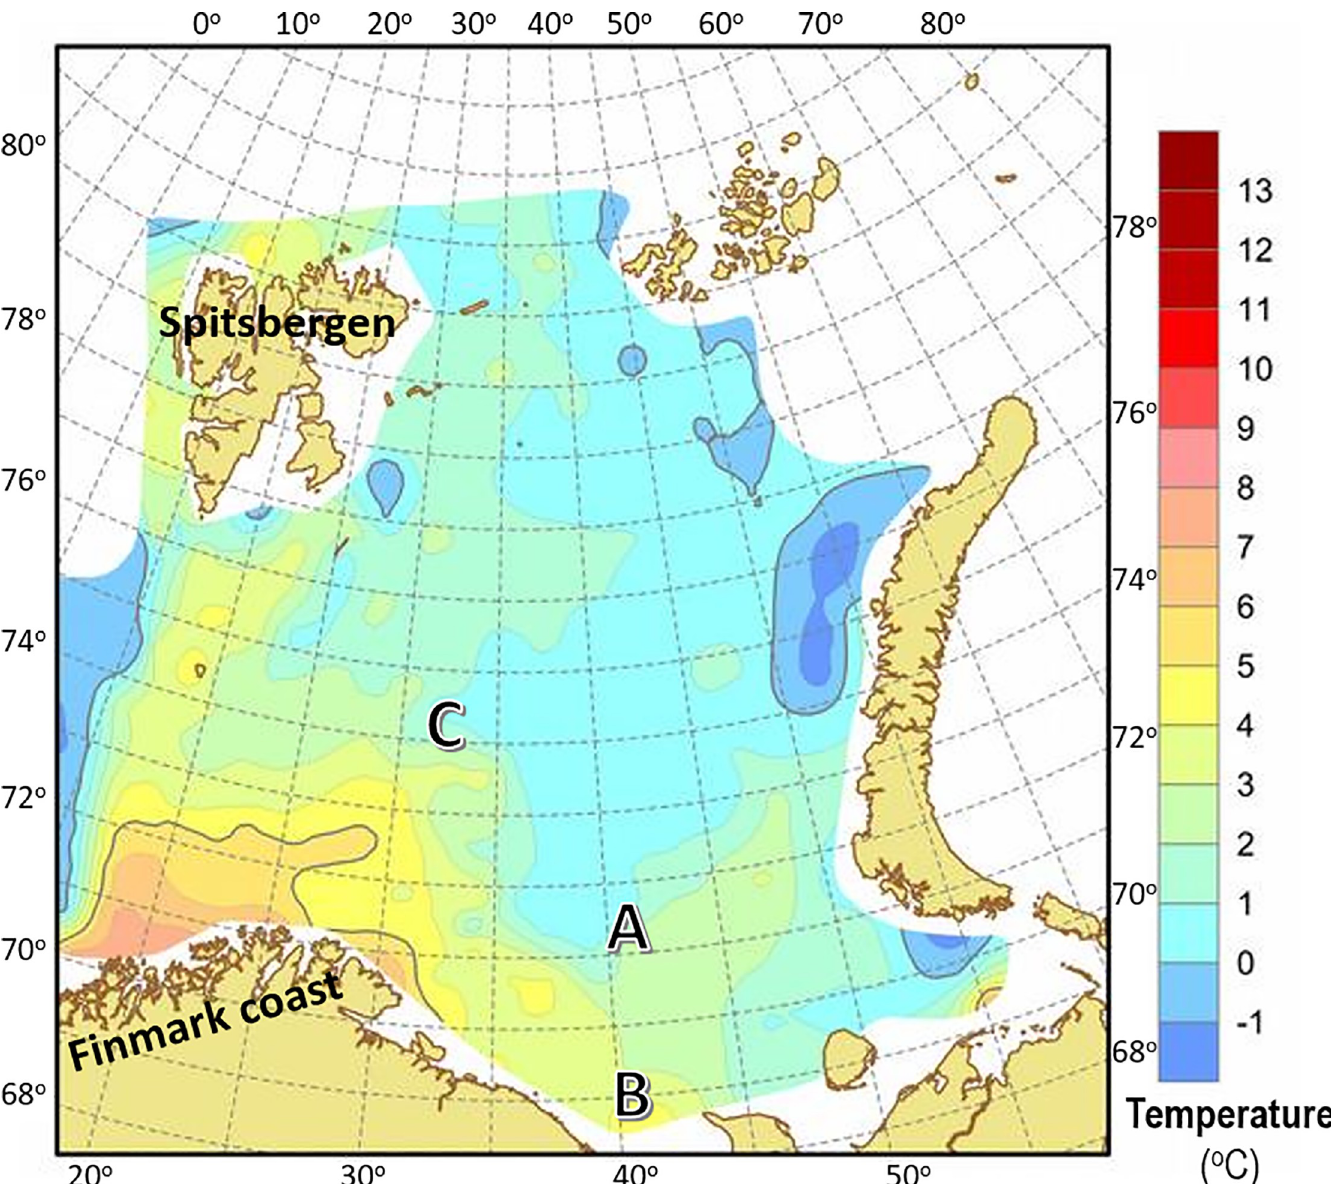
Fig 3. Distribution areas of wild Northeast Arctic cod in the Barents Sea. The three main studied areas (A, B, and C) and different bottom temperatures ( o C) are illustrated. Area A was between North Kanin Bank and Eastern Basin, area B was Kanin Bank, and area C was Central Bank, with average bottom temperatures of 1.61 o C, 3.45 o C, and 1.69 o C, respectively. The dataset of individual weights, pyloric caecal activity ratio of trypsin to chymotrypsin (T/C ratio), and condition factor (CF) of the wild Northeast Arctic cod was available [12]. Latitudes and longitudes are indicated on the frame. The picture was obtained from the routine cruise survey conducted by the Institute of Marine Research,